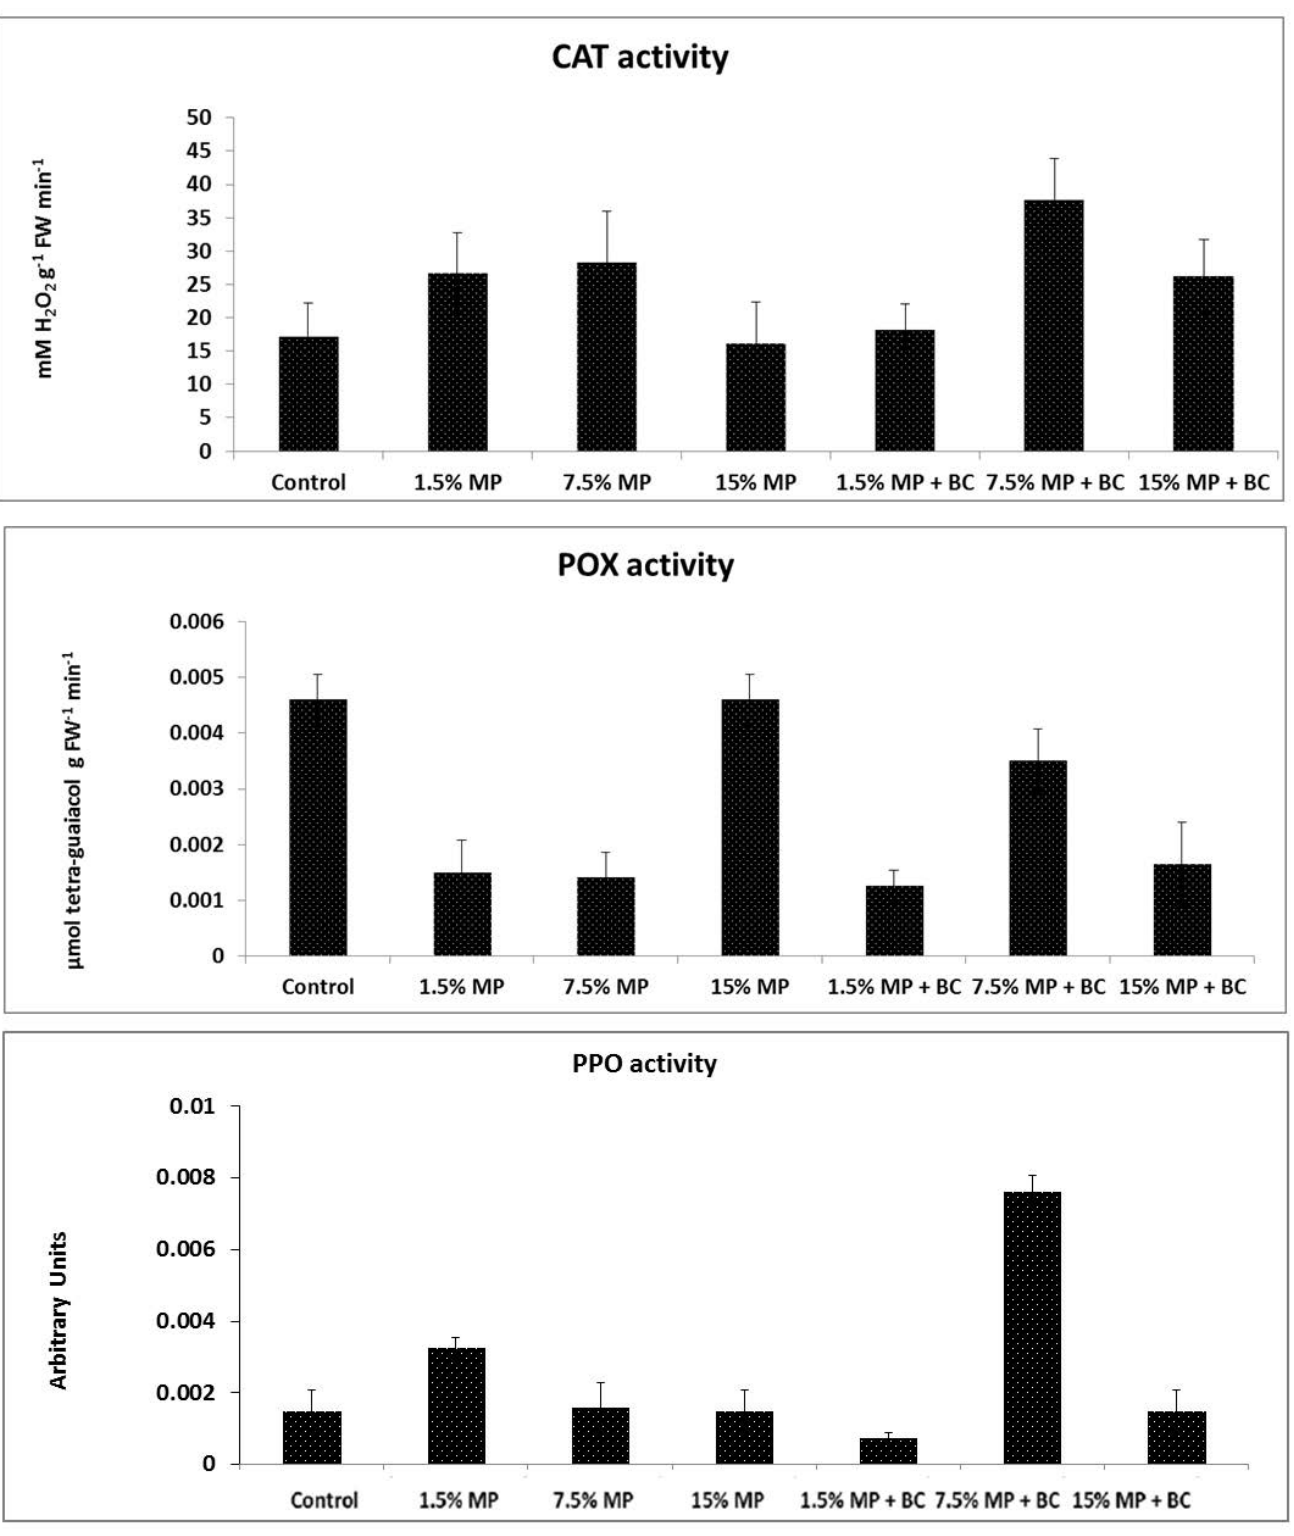
Figure 3. Biochar effects on the enzymes’ activity in Vicia faba plants affected by microplastic in soil. CAT: Catalase, POX: Peroxidase, PPO: Polyphenol